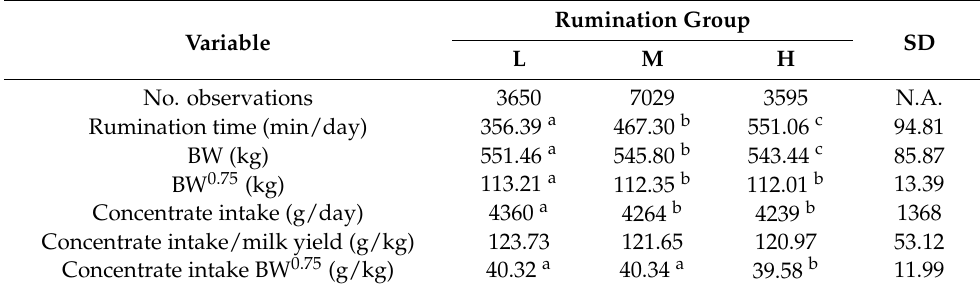
Table 2. Estimated marginal means for rumination time, body weight, and concentrate intake of low (L), medium (M), and high (H) rumination cows.